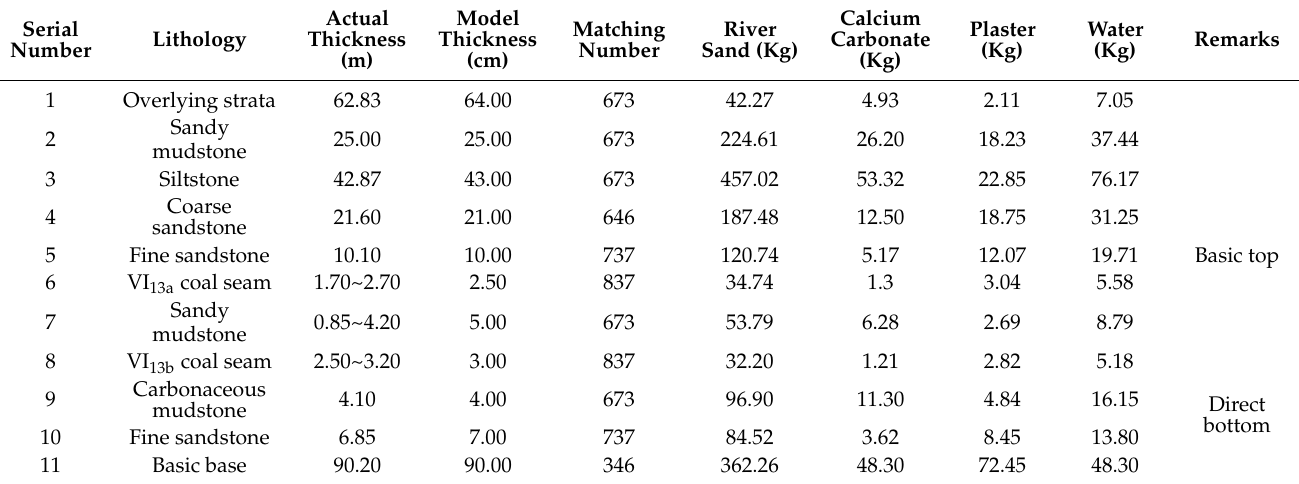
Table 3. Proportion and dosage of similar